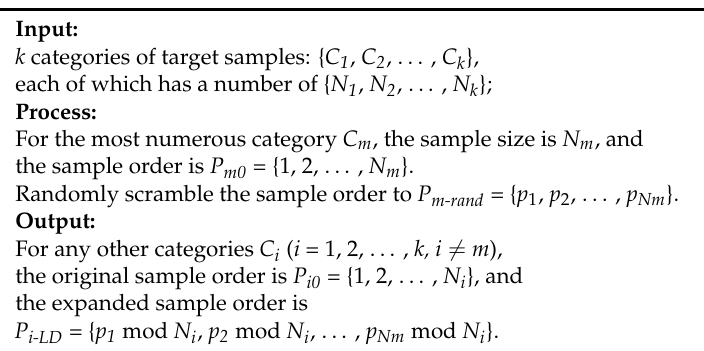
Table 2. Algorithm steps of label